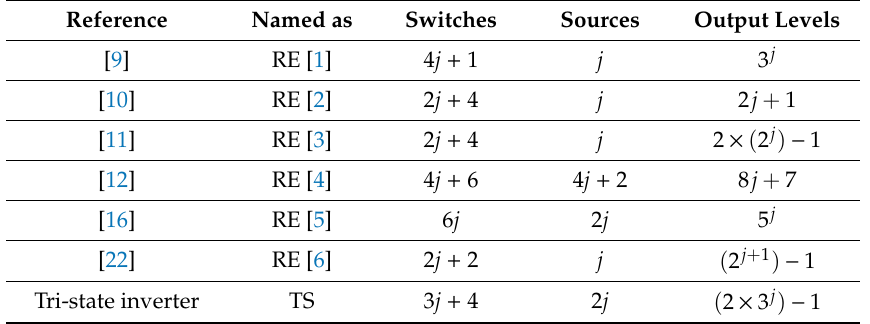
Table 6. Circuit parameter count comparison of MLI in terms of the number of structures. Reference Named